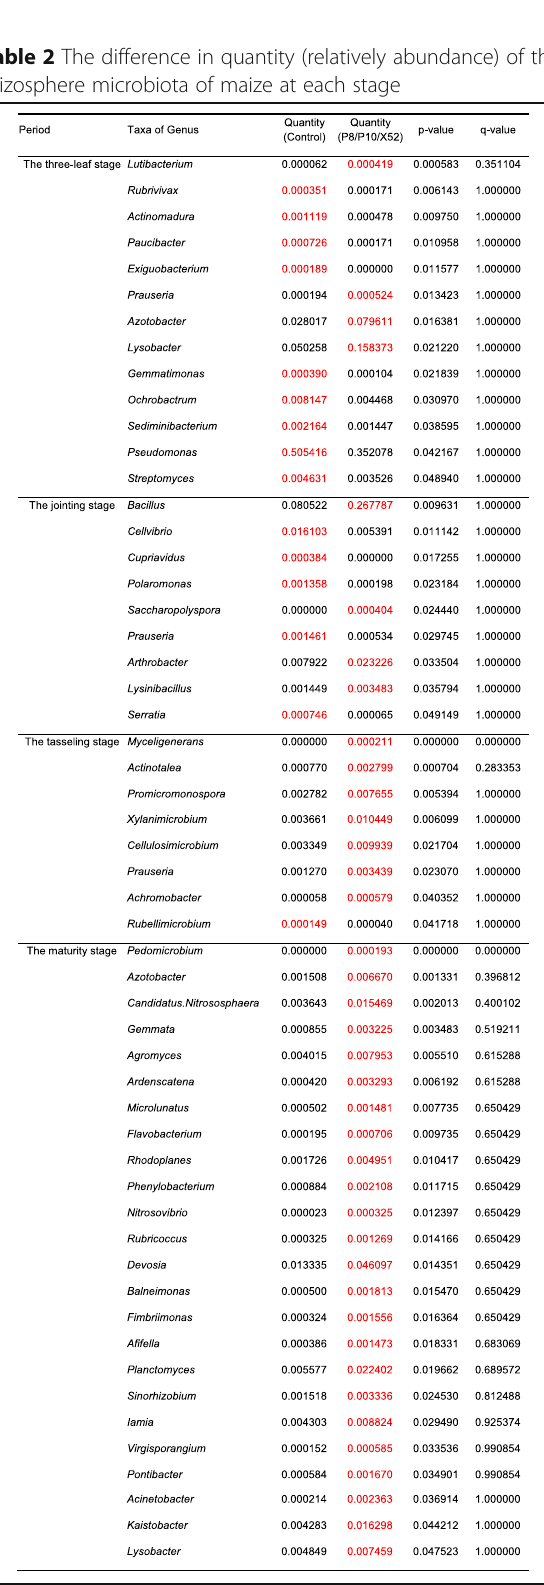
The quantity is relatively abundance, red indicates that the genus quantity is higher in that